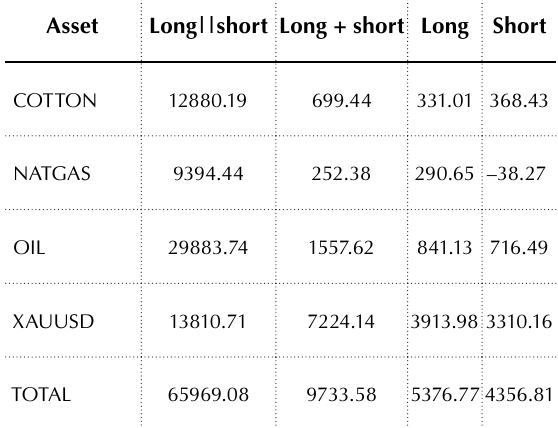
Table 9. Table of correlation coefficients between backtesting periods of the three PIVOT systems on OIL